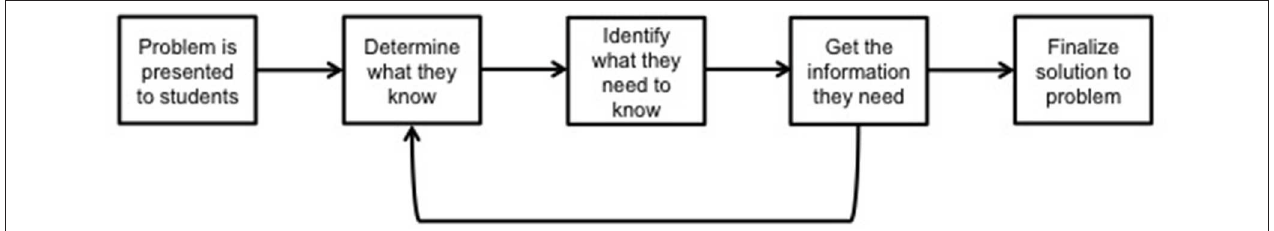
FIGURE 1 | The Problem-Based Learning